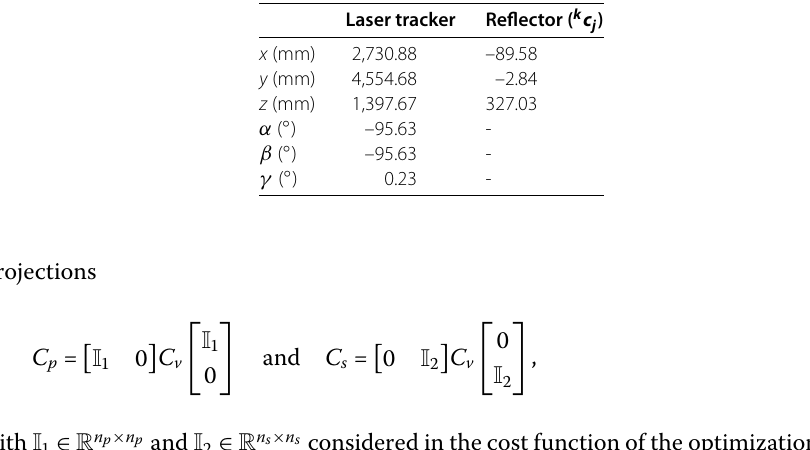
Table 3 Position and orientation of laser tracker and reflector